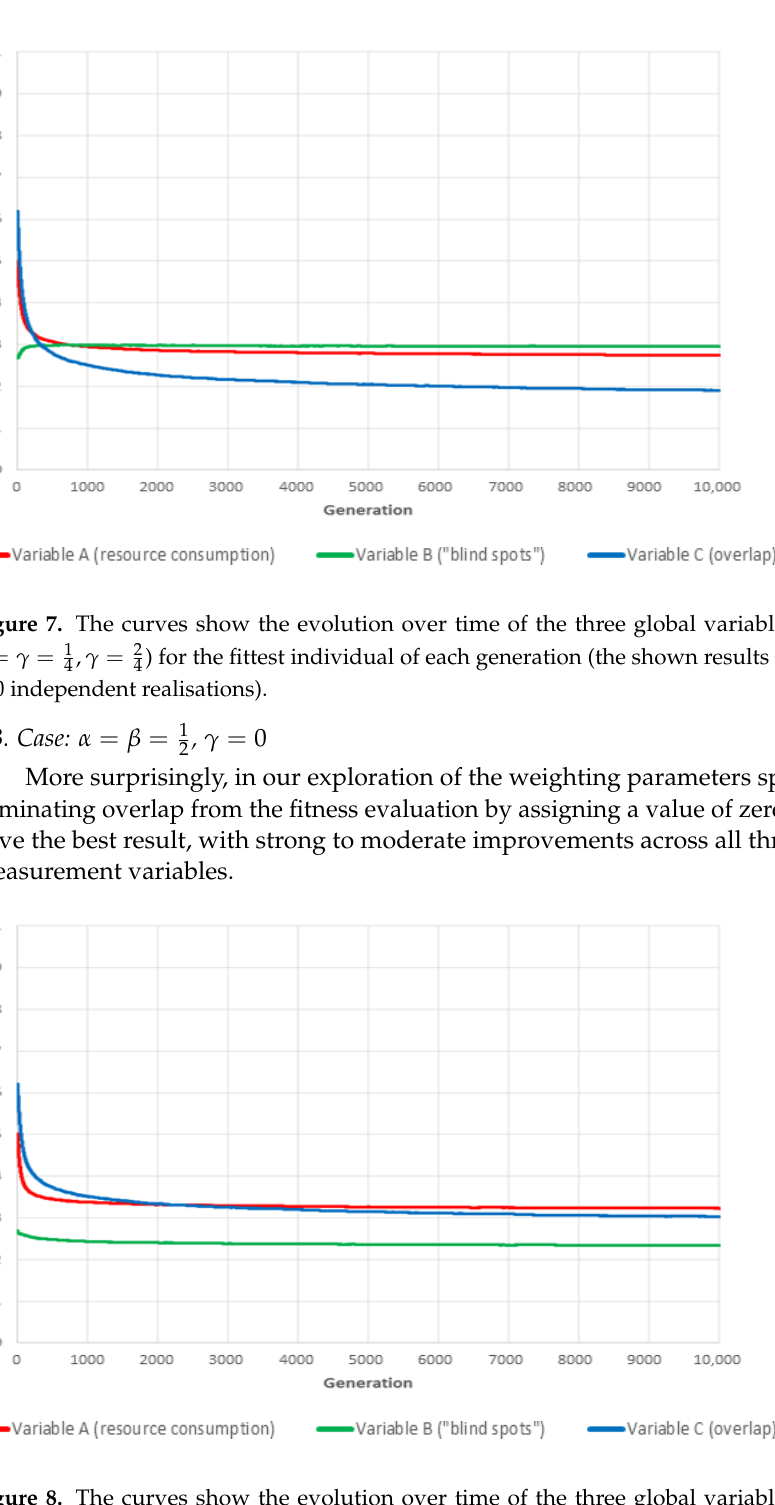
Figure 8. The curves show the evolution over time of the three global variables (for the values α = β = 1 , γ = 0) for the fittest individual of each generation (the presented results are the averages 2 over 180 independent